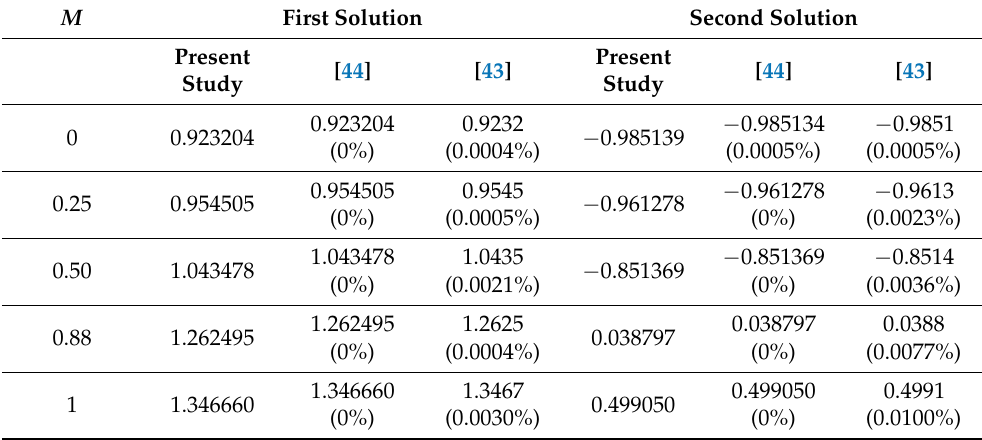
Figure 13. Analysis of solution stability.